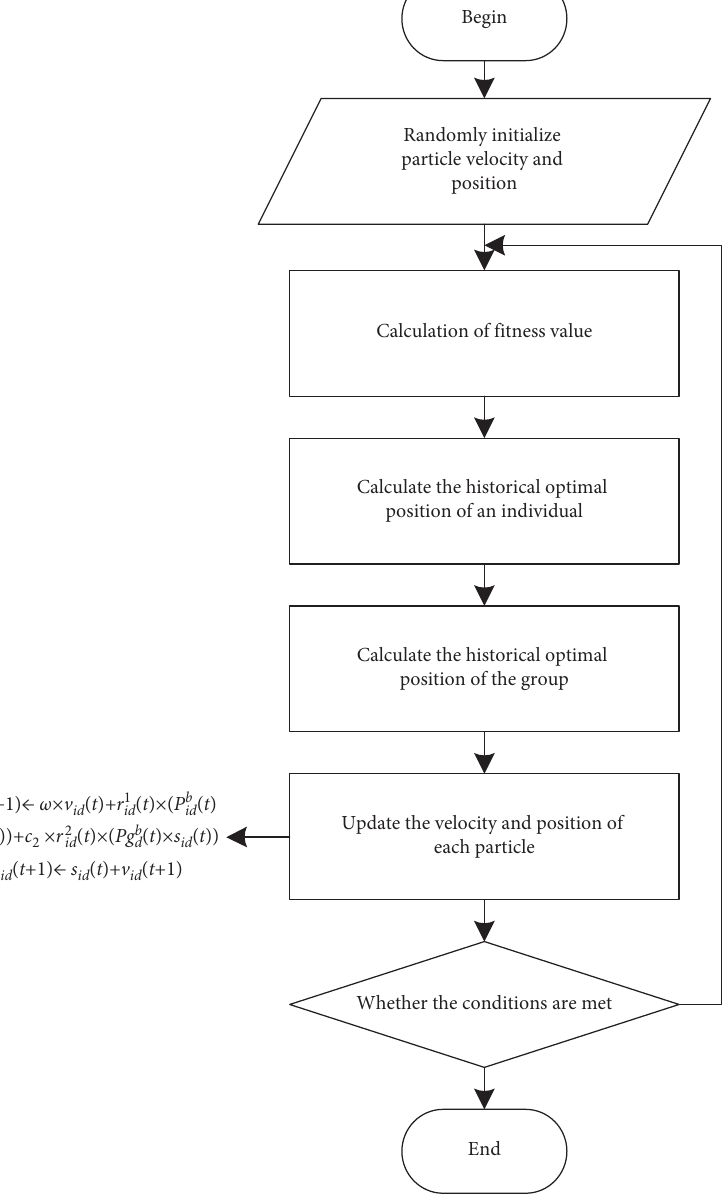
Figure 2: Flow chart of basic particle swarm optimization